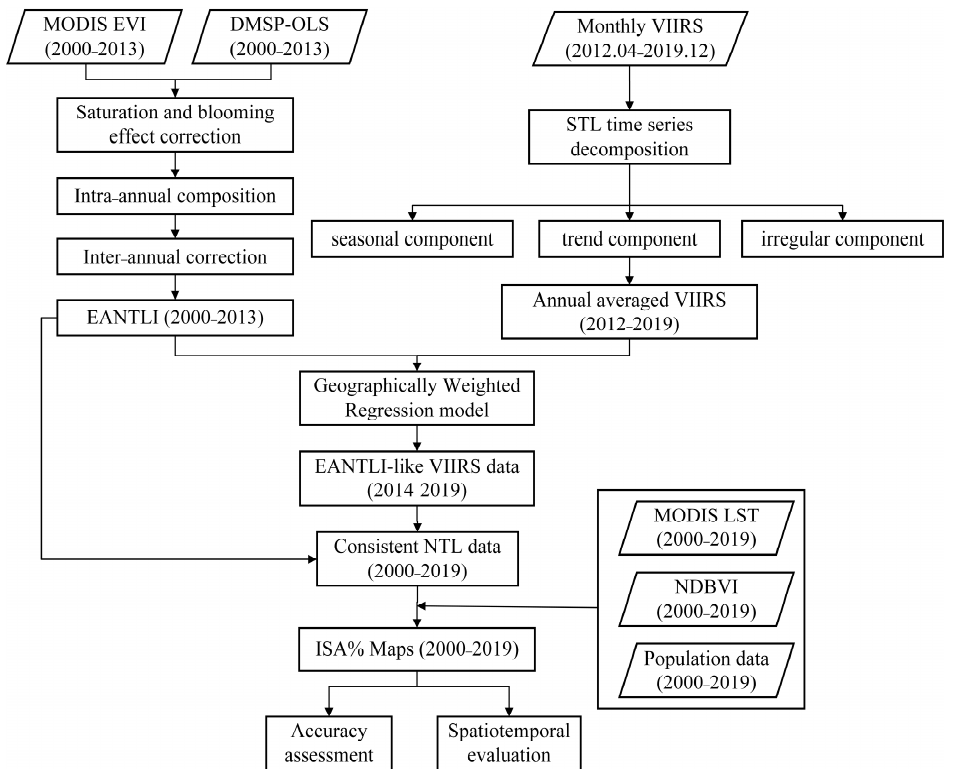
Figure 2. Flowchart of the proposed ISA% mapping model.